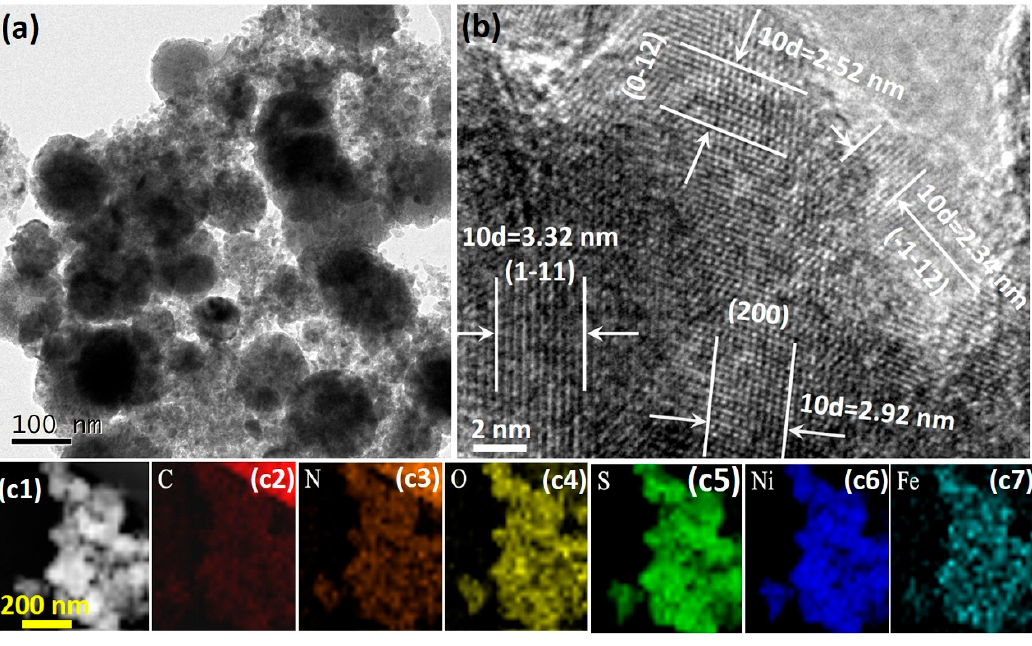
Figure 3. ( a ) The TEM, ( b ) HR-TEM, and ( c ) the corresponding elemental mapping images of the Fe-NiS 2 /C-30 sample.